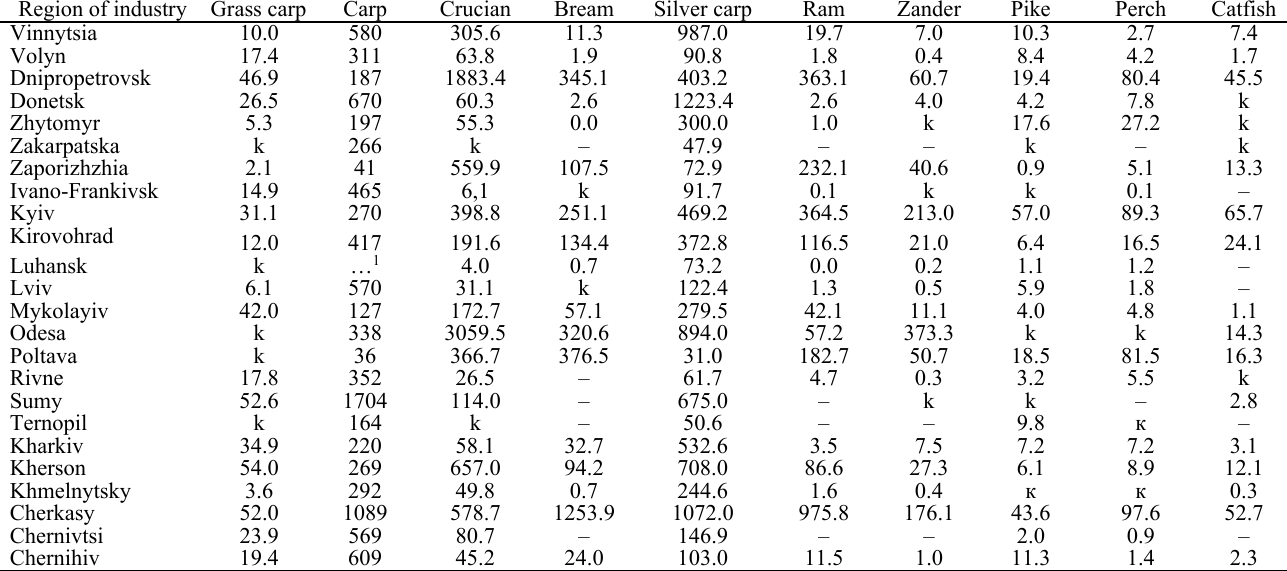
The structure of fish caught by region in the inland waters of Ukraine in 2019, t (according to the State Statistics Service of Ukraine) (Derzhavna sluzhba statistiki Ukrayini) Region of industry Grass carp